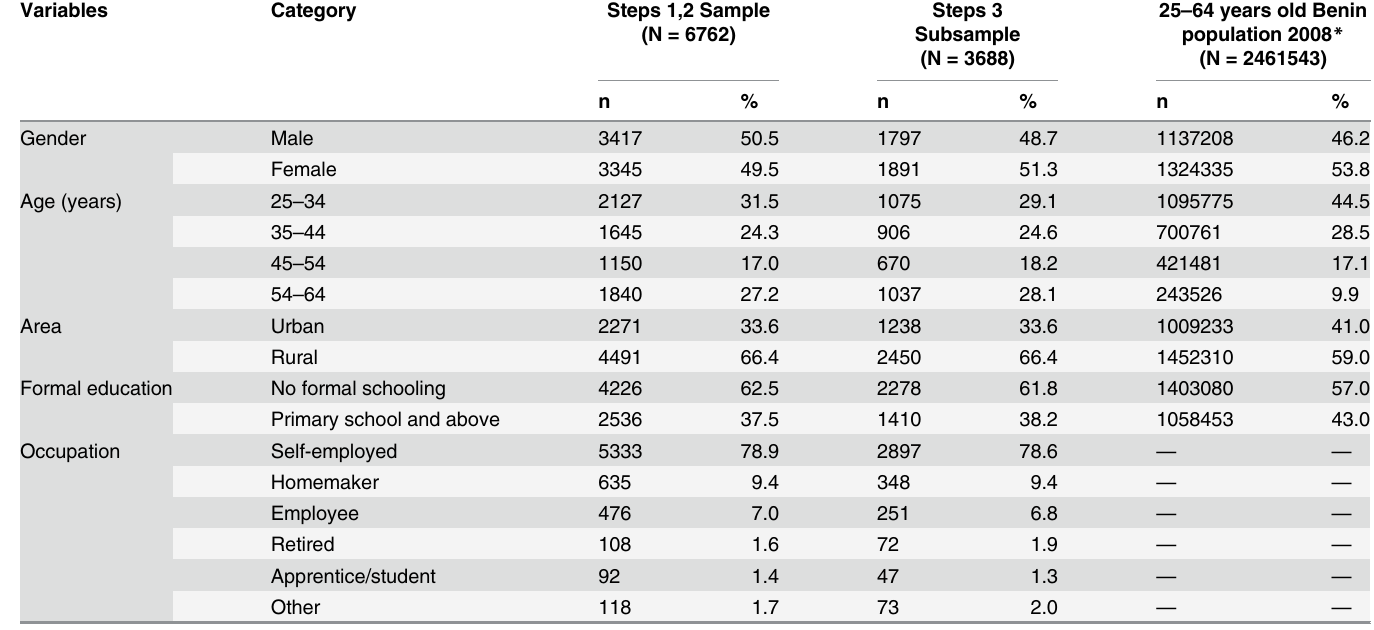
Table 1. Sociodemographic characteristic of Steps participants compared to the 25 – 64 years old population in Benin (Benin population from Na- tional Health statistic 2008).